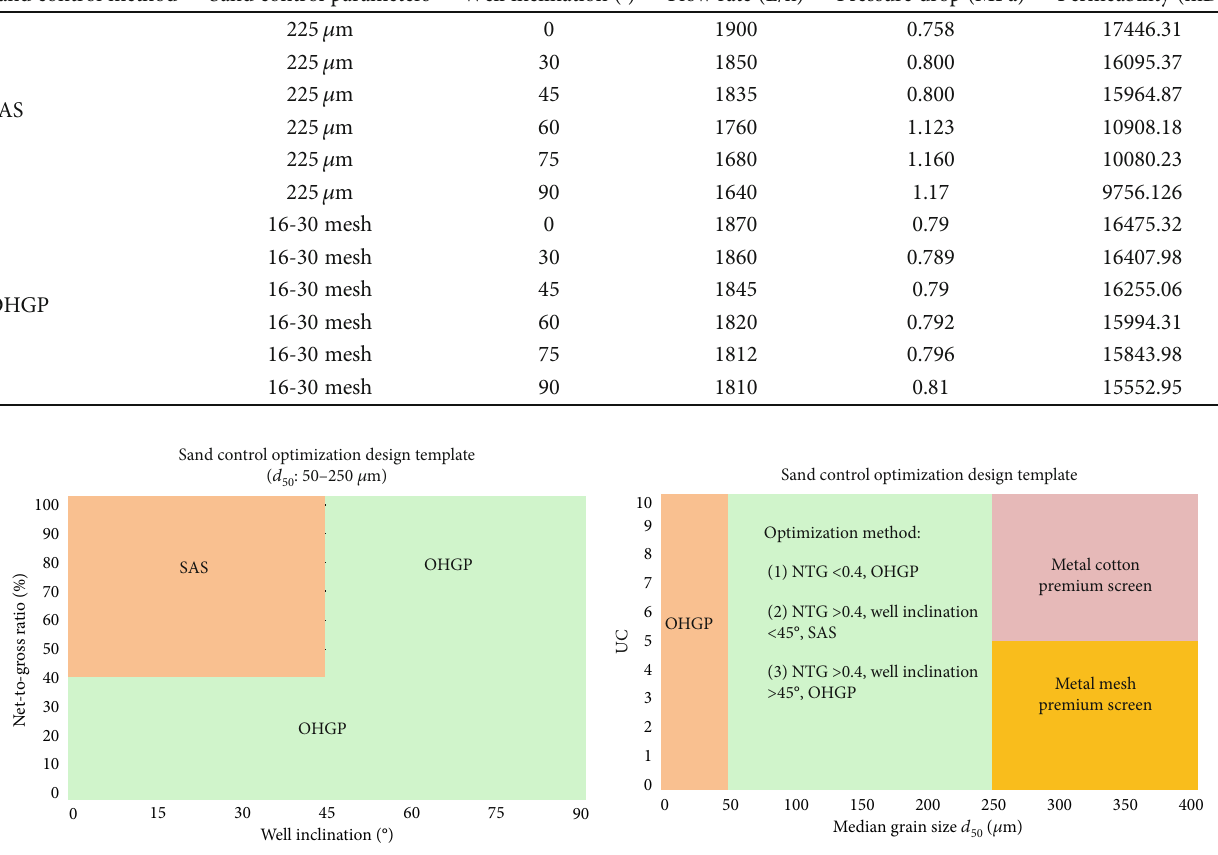
Table 3: Experiments of the e ff ect of well inclination on the blockage of a screen under directional wells. Sand control method